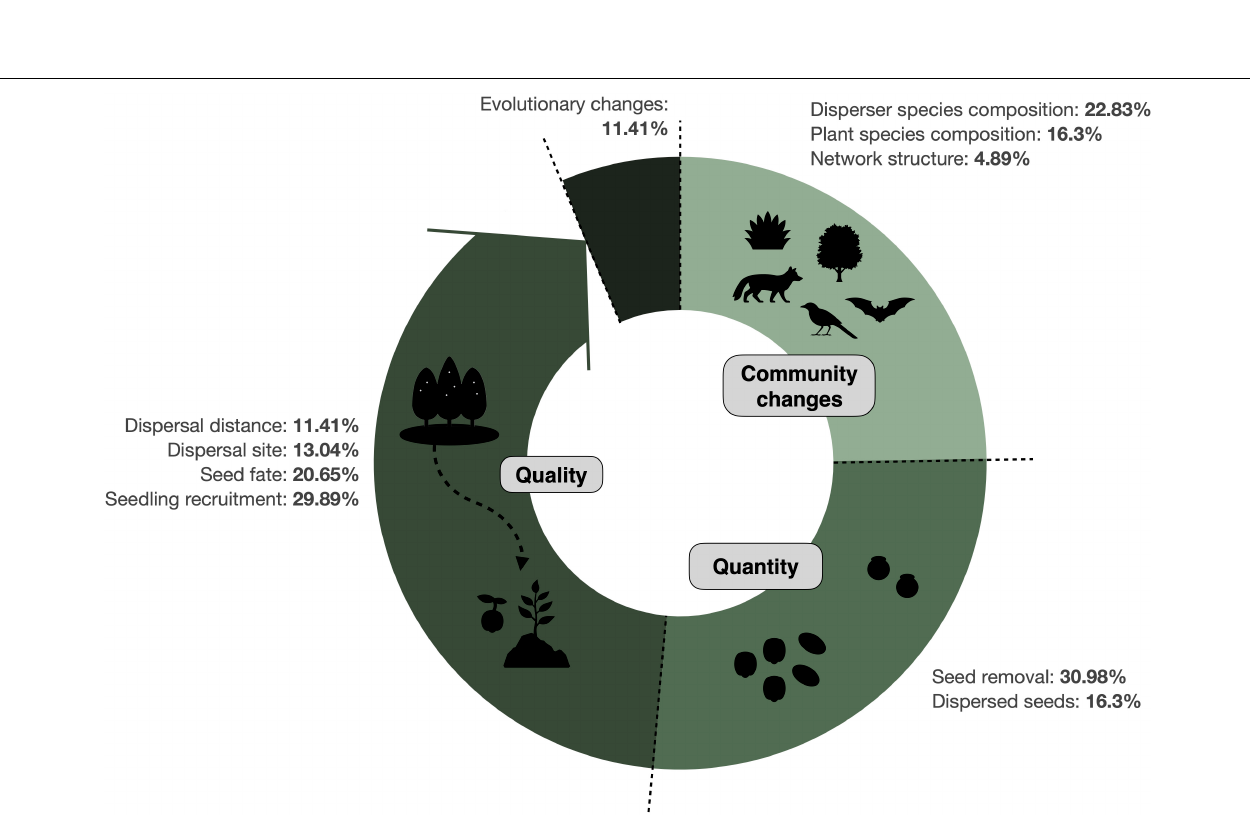
FIGURE 4 | Response variables measured in SDD studies. Doughnut chart illustrates how SDD occurred along the seed dispersal process (represented in the direction that happens in nature) by causing community changes, disruptions in the quantity and in the quality components of seed dispersal, as well as evolutionary changes. Shown are the percentage of studies evaluating disruptions for each individual response variable ( N = 327 records). See Table 2 for further details on the definition of these